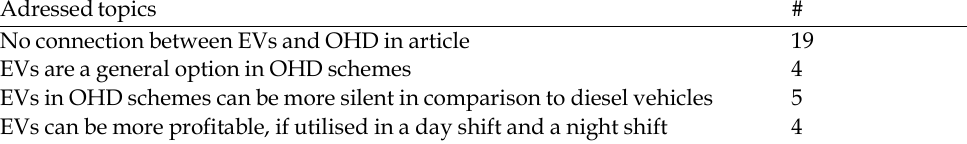
Table 1. Number of papers and types of advantages of EVs discussed in OHD schemes Adressed